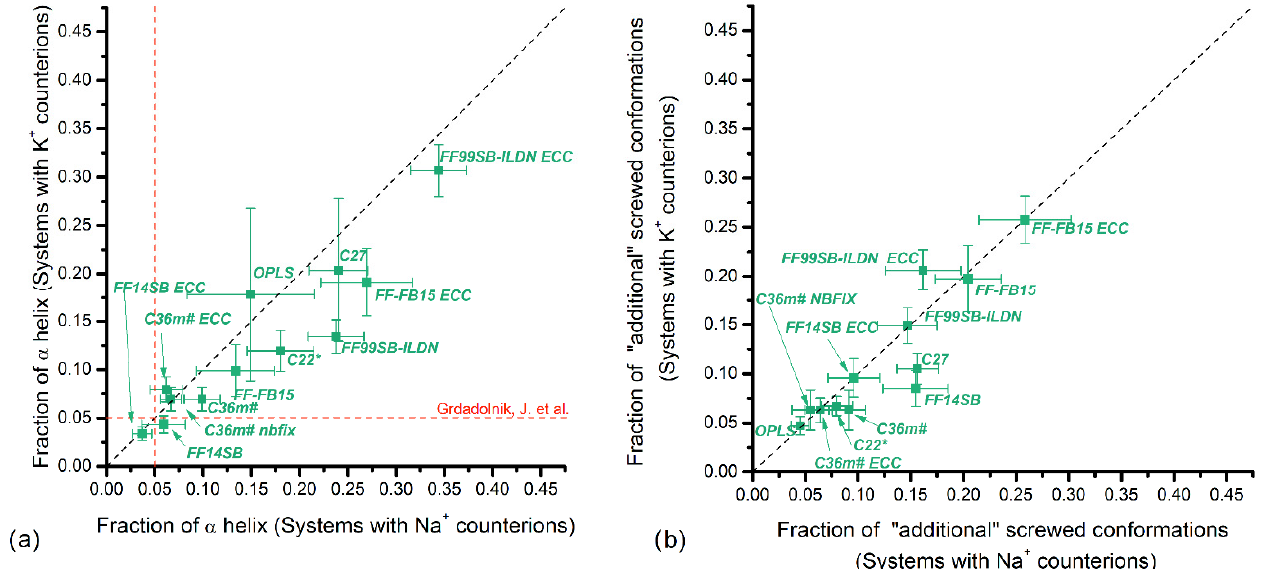
Figure 4. PASA: Fractions of ( a ) α R -helical and ( b ) 3.10-helical (for CHARMM force fields) and the “additional screw” conformations (for AMBER and OPLS force fields) with Na + vs. K + counterions. Vertical and horizontal dashed lines correspond to available experiment data.